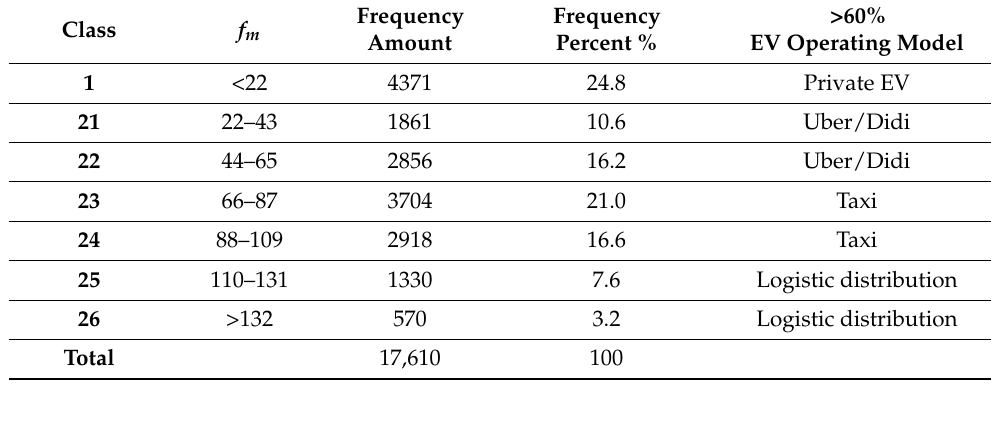
Table 3. Summary of verified EV operating modes.